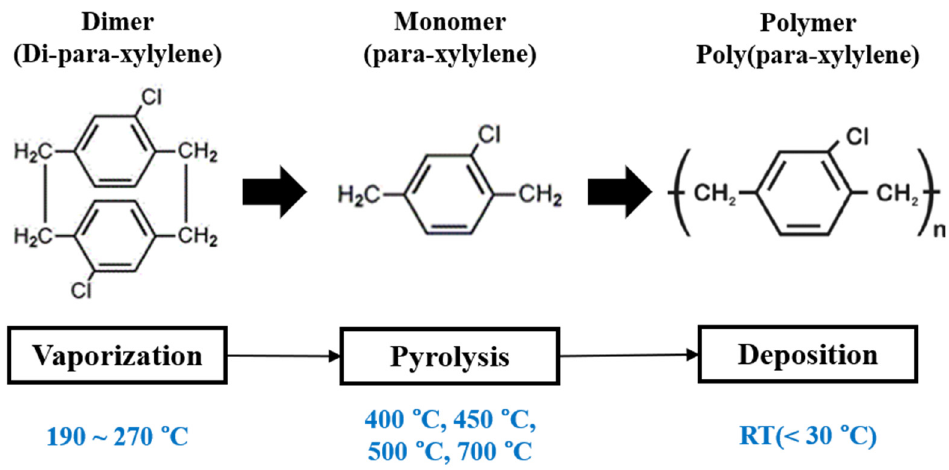
Figure 1. Molecular structure and schematic mechanism for the chemical vapor deposition process of visible parylene-C.